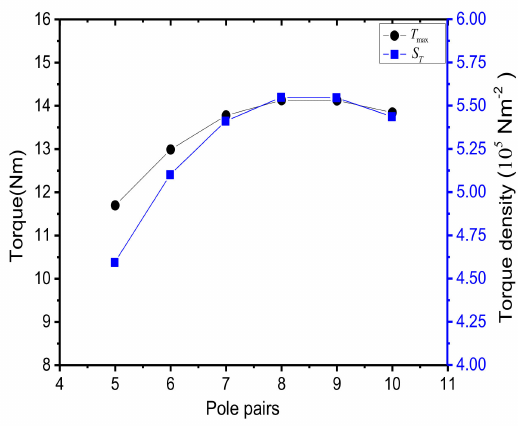
Figure 12. T max and S T versus pole